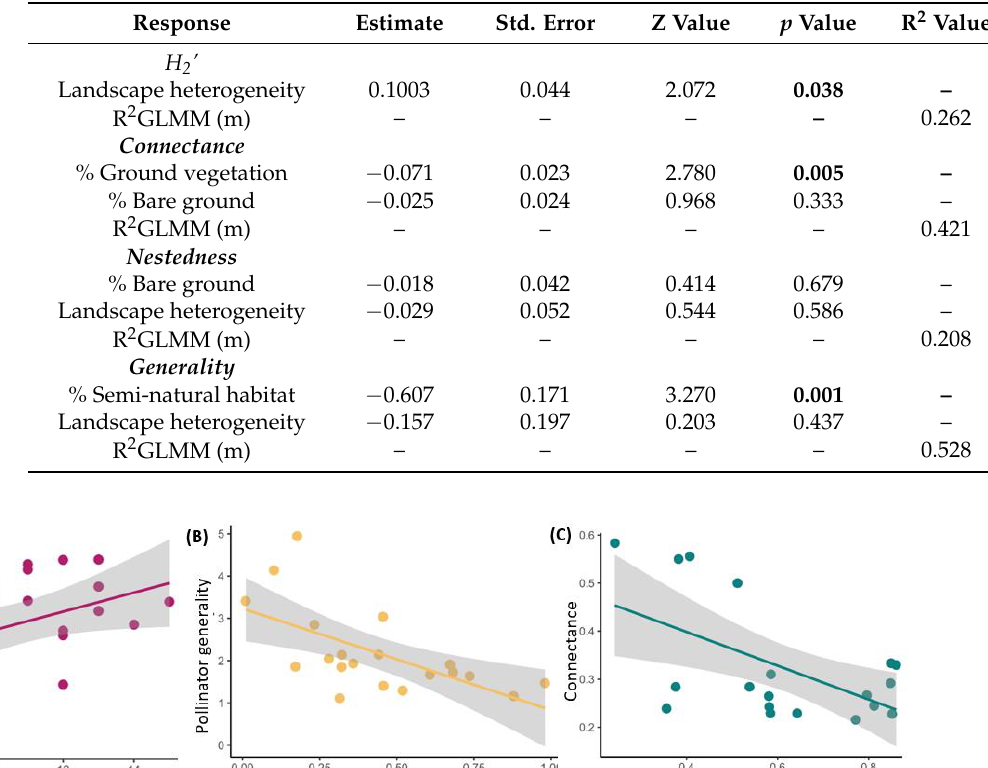
Table 1. The final results of the averaged linear mixed models with AIC < 2 for our pollen-based plant-pollinator networks. The full models included the following predictor variables: percent ground vegetation, percent bare ground, percent flower abundance, percent semi-natural habitat within a 2 km radius, and landscape heterogeneity.